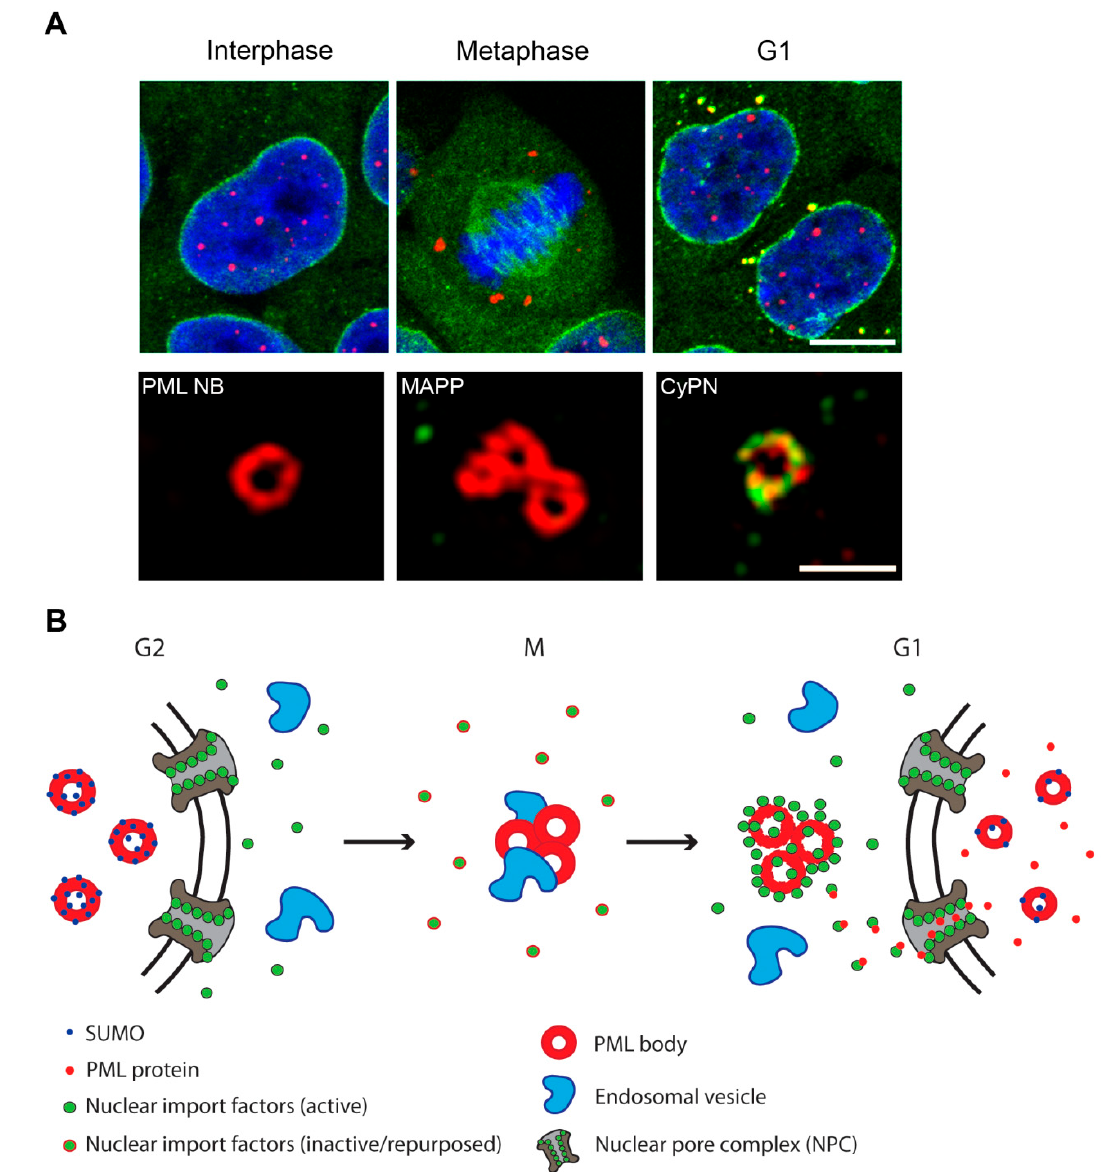
Figure 1. PML bodies at different stages of the cell cycle. ( A ) Upper panel: Confocal images of fixed HaCaT cells. DAPI (blue), PML (red), Importin β (green). Scale bar 10 µm. Lower panel: Super-resolution structured illumination microscopy (SIM) images showing PML bodies in fixed HaCaT cells. PML (red), FG-containing NUPs (green). Scale bar 1 µm. PML NB (PML nuclear body), MAPP (mitotic accumulation of PML proteins), CyPN (cytoplasmic assemblies of PML and nucleoporins). Images have been reproduced from Lång et al. ([95], www.tandfonline.com) ( B ) Schematic illustration of PML bodies in mitosis. At entry into mitosis, PML bodies aggregate, become de-SUMOylated, and associate with endosomal vesicles. Nuclear import factors become inactivated or repurposed during mitosis and re-activated at exit from mitosis to engage in import of nuclear components (please see main text for more details).